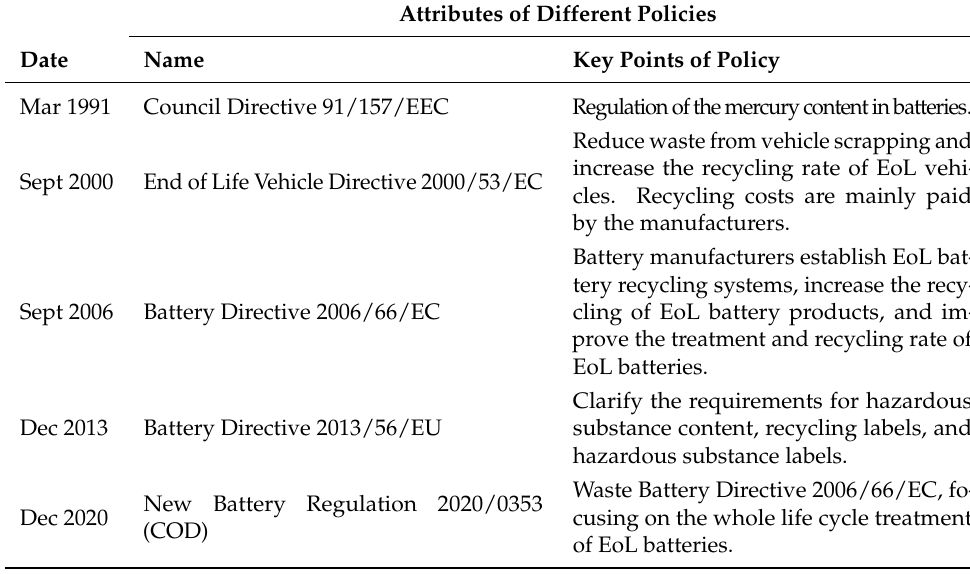
Table 1. Relevant regulations on EoL power battery recycling in the